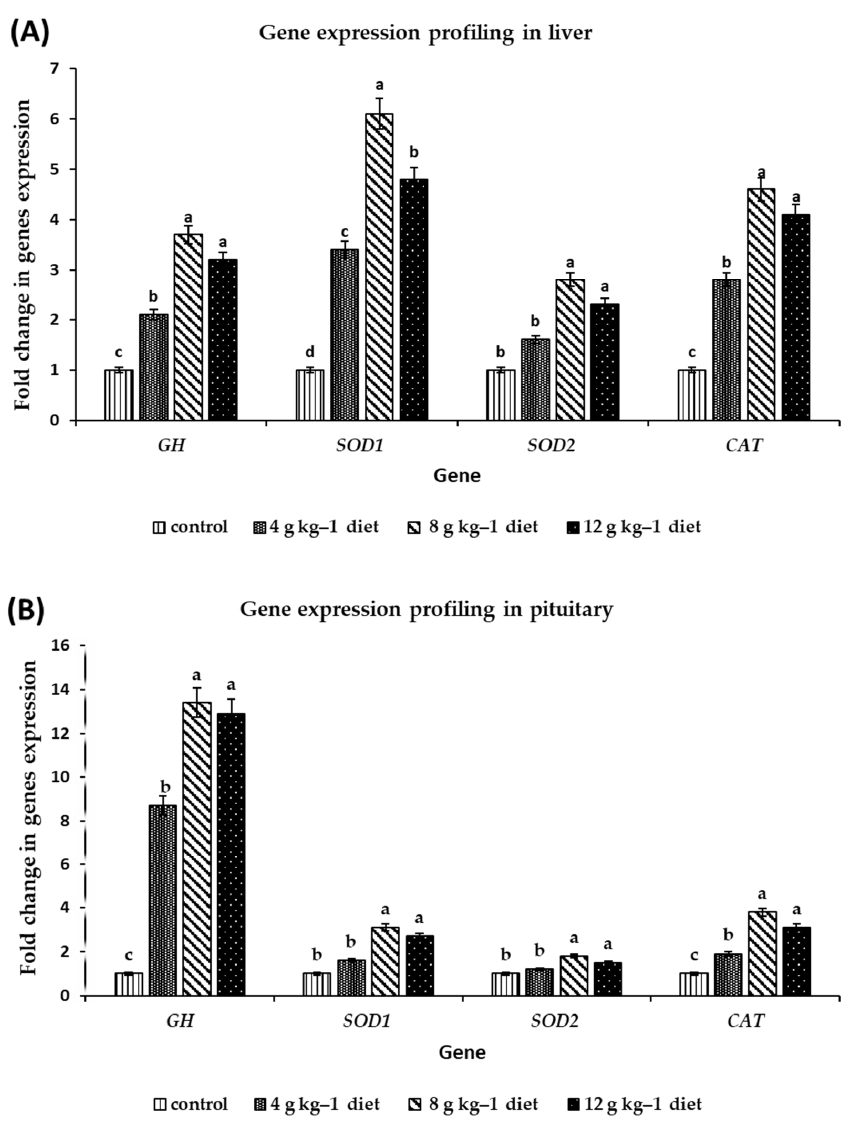
Figure 2. Differential expression of GH ; Superoxide dismutase (Cu/Zn) ( SOD1 ), mitochondrial superoxide dismutase (Mn), ( SOD2 ), and catalase ( CAT ); genes in liver ( A ) and pituitary ( B ) tissues of Muscovy grower ducks ( C. moschata ) as a result of feeding on diets supplemented with different levels of S. marianum dry seeds (4, 8 and 12 g kg − 1 diet) as well as control at the end of the experiment (after 4 weeks). The expression patterns were estimated after normalization with the β‐ Actin gene [32]. a,b,c : Bars within the same attribute not sharing a common letter are significantly different ( p < 0.05).